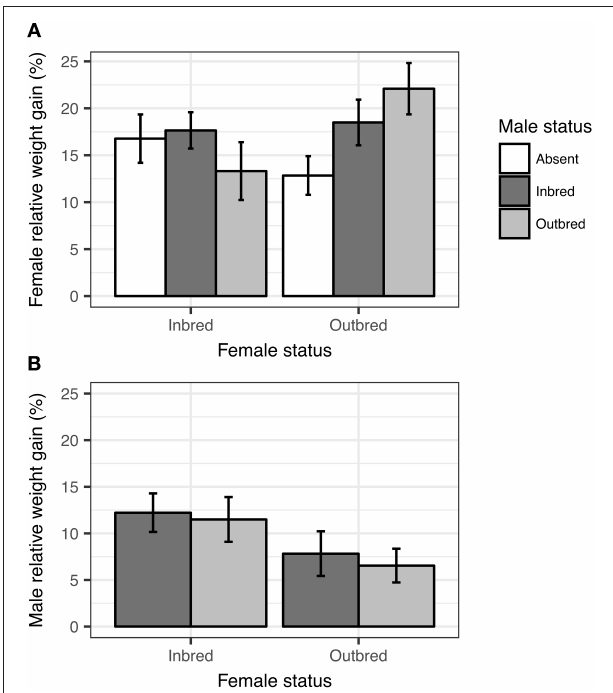
FIGURE 2 | Effects of maternal inbreeding (inbred or outbred) and male status (inbred, outbred, or absent) on female relative weight gain (A) , and male relative weight gain (B) over the breeding attempt. Mean ±